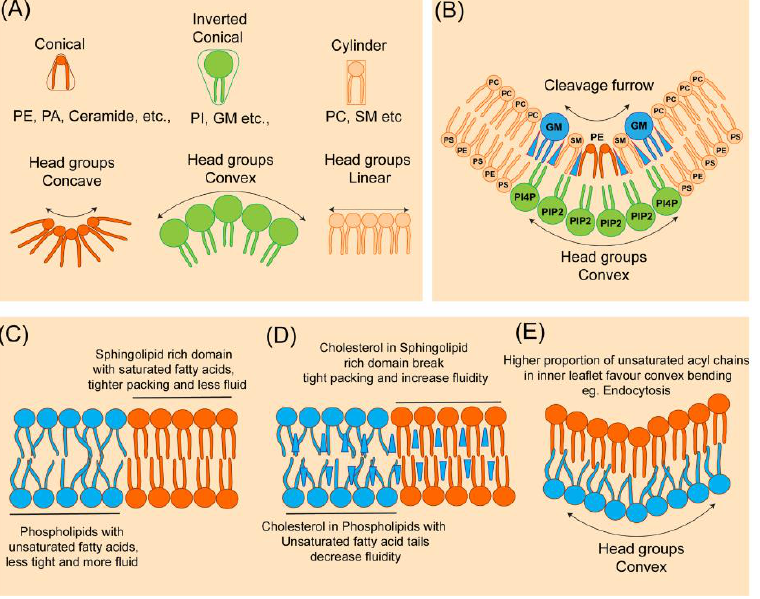
Figure 2. Chemical and physical properties of lipids and their influence on membrane curvature during cytokinesis. ( A ) Lipid shape is based on the cross-sectional area of the head group relative to their fatty acid acyl chains. ( B ) Representative lipid composition at the cleavage furrow of a typical mitotic cell. ( C , D ) Lipids with saturated fatty acids tend to pack more tightly than unsaturated fatty acid-containing lipids, and as a result, they are less flexible and rigid ( red ). However, when cholesterol is present, it can prevent the tight packing of saturated fatty acid-containing lipids and thus increase fluidity. In contrast, cholesterol increases the packing density of unsaturated fatty acids and thus reduces fluidity in these lipid domains. ( E ) Unsaturated fatty acid-containing lipids in the inner leaflet of the plasma membrane favor convex bending, for instance in the case of endocytosis.